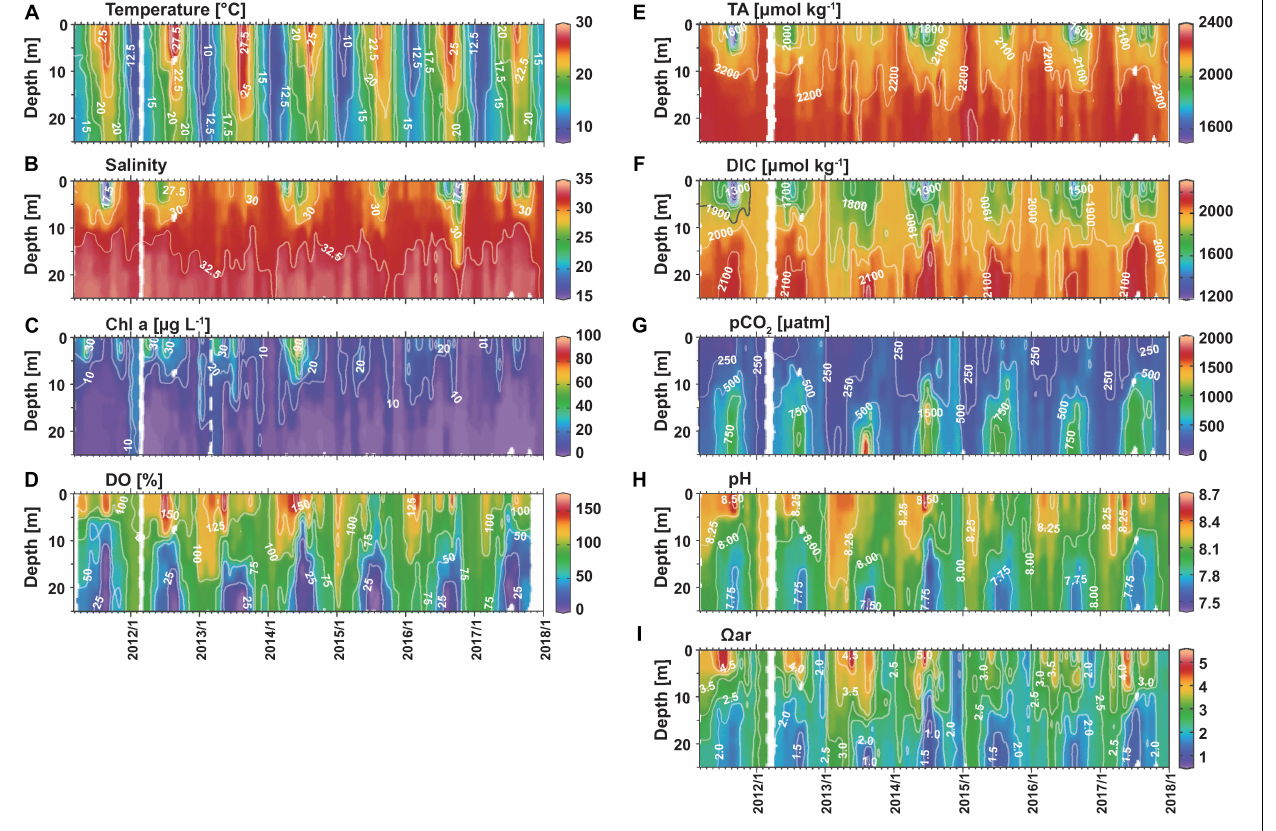
Frontiers in Marine Science |